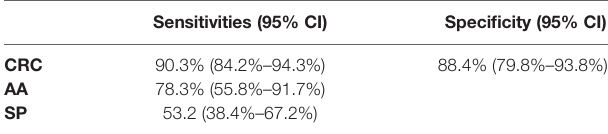
TABLE 3 | The sensitivities and speci fi cities of CRC, AA and SP.